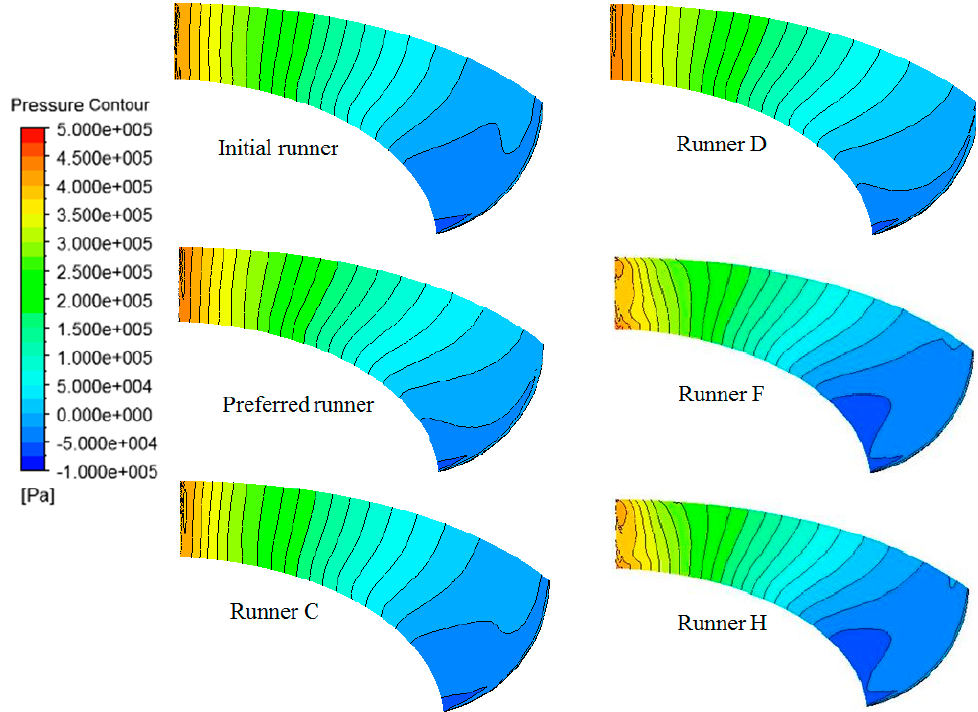
Figure 11. Pressure distribution on suction surface for different runners.